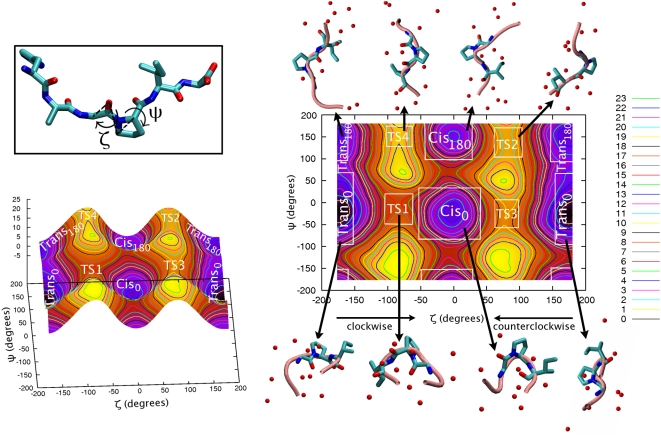
PEPT-WAT.Free energy (kcal/mol) of the /HAGPIA/ peptide in solution as a function of the dihedral angles ζ and ψ (in degrees, showed in the inset). The plot is divided in transition and minima regions, with representative structures (center of the lower free energy cluster within each minima and TS region) for each region explicitly shown (See Text S1 for details), along with water molecules within a shell of 2 Å (red spheres).